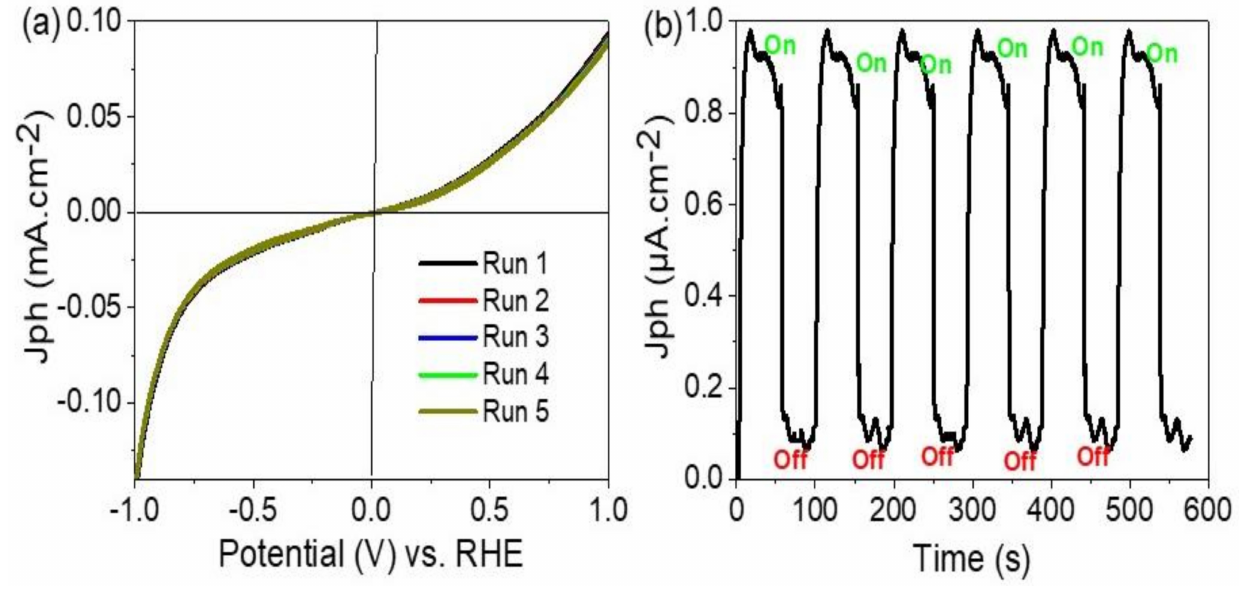
Figure 4. ( a ) The J ph —potential relation with repeating five runs, ( b ) on/off chopped light for the prepared ATO/PANI/PbI 2 nanocomposite photoelectrode at 25 ◦